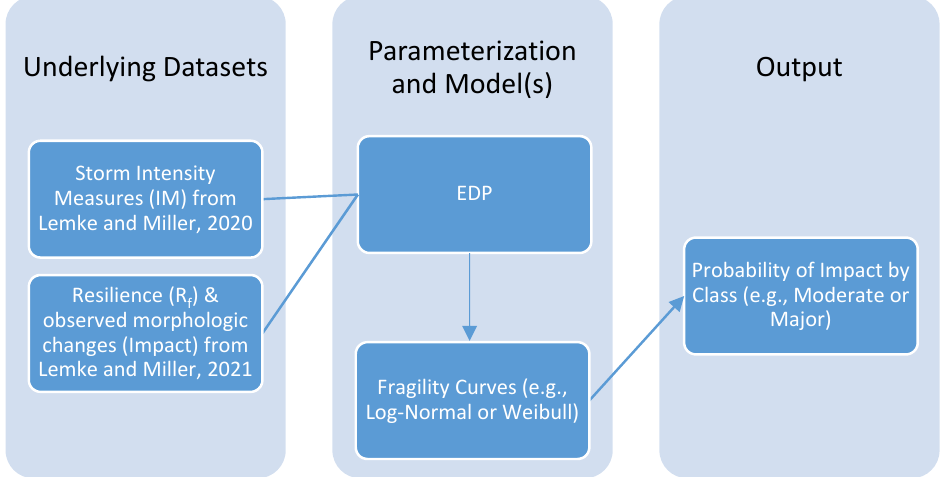
Figure 4. Conceptual flowchart to highlight sources of previously published data used to generate the EDP and subsequent fragility curves.